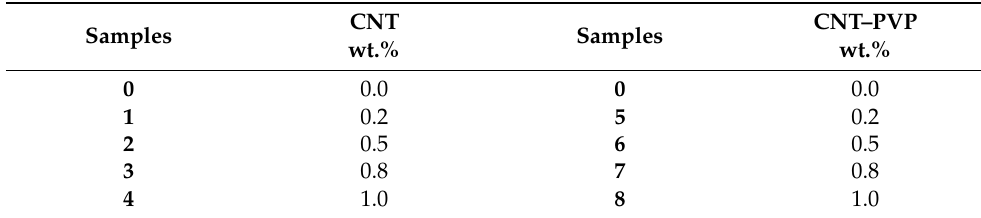
Table 1. The composition of the samples.